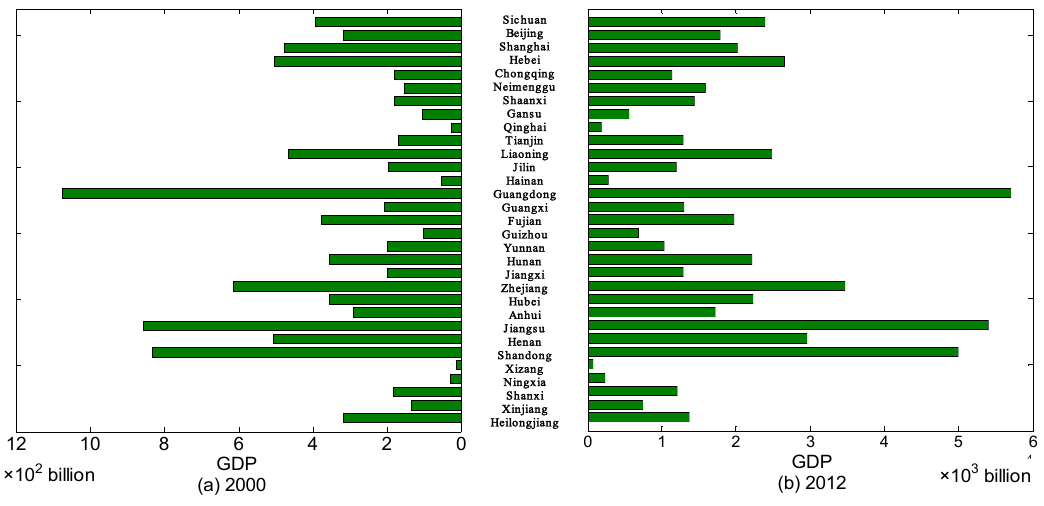
Figure 1 . Distribution of GDP in mainland China in ( a ) 2000 and ( b ) 2012. Figure 1. Distribution of GDP in mainland China in ( a ) 2000 and ( b )